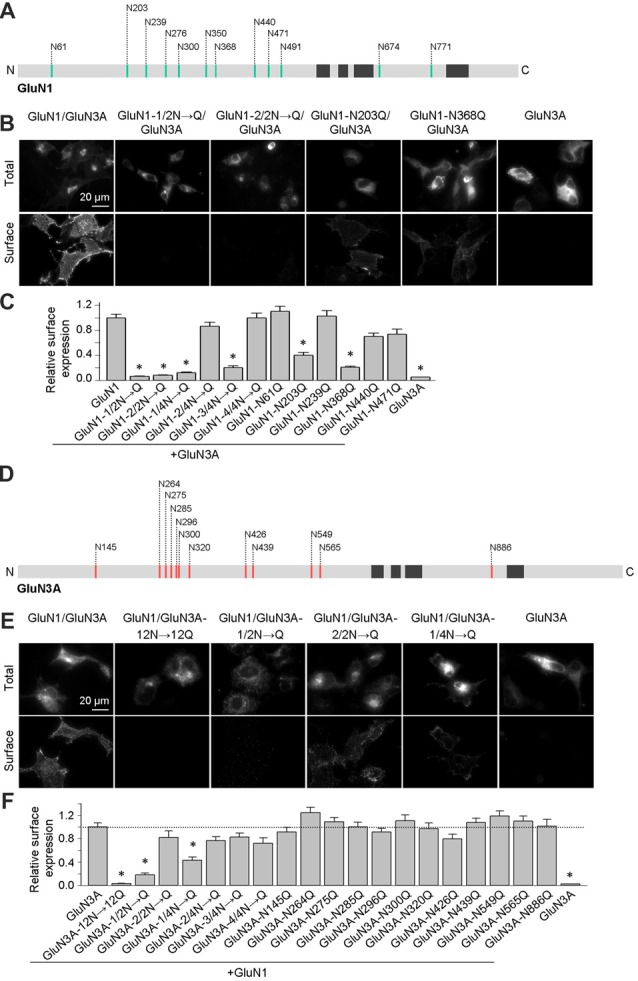
Altered surface expression of GluN1/GluN3A receptors lacking specific N-glycosylation sites. (A,D) Schematic diagram of the 12 consensus N-glycosylation sites (N-X-S/T) in the GluN1 (A) and GluN3A (D) subunits. N = N-terminus; C = C-terminus; black rectangles indicate membrane domains. (B,E) Representative images of total and surface wild-type and mutant GluN1–4a/GFP-GluN3A (hereafter referred to as GluN1/GluN3A) receptors or GluN3A subunits expressed in COS-7 cells, immunostained 24 h after transfection. (C,F) Summary of the relative surface expression of the indicated NMDAR subunits measured using fluorescence microscopy (n ≥ 54 cells per group). *p < 0.05 vs. GluN1/GluN3A (ANOVA). In this and subsequent figures, all summary data are presented as the mean ± SEM.